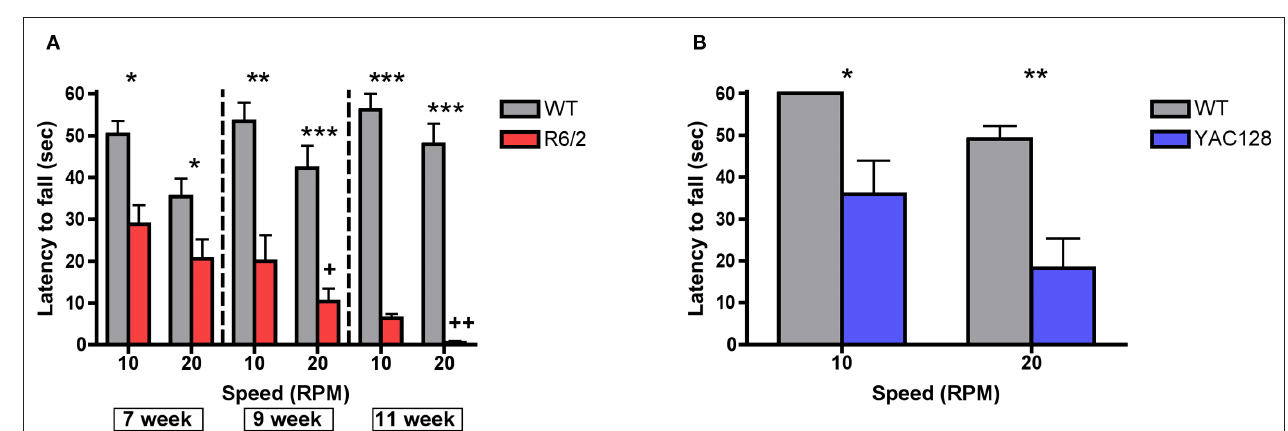
Figure 2 | rotarod performance in (A) r6/2 transgenic mice (7 weeks, n = 22 WT, 23 r6/2; 9 weeks, n = 15 WT, 13 r6/2; 11 weeks, n = 14 WT, 6 r6/2) and (B) 7-month-old YAC128 transgenic mice ( n = 7 WT, 9 YAC128). All data are mean ± SEM. * Indicates significantly different from WT, p < 0.05; ** indicates p < 0.001; *** indicates p < 0.005; + , ++ R6/2 week 7 vs. weeks 9 and 11 ( p < 0.05, 0.01,